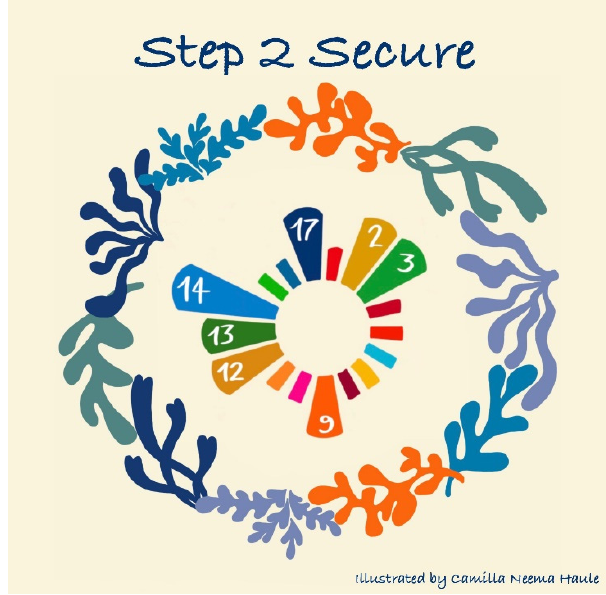
Figure 2. A case study relevant to the EU food on the integral ecology approach to food novelty applied to seaweed (frame of the illustration) through the lens of the systematic approach to the Agenda 2030 [42]. Illustration for SECURE by Camilla Neema Haule 2021.